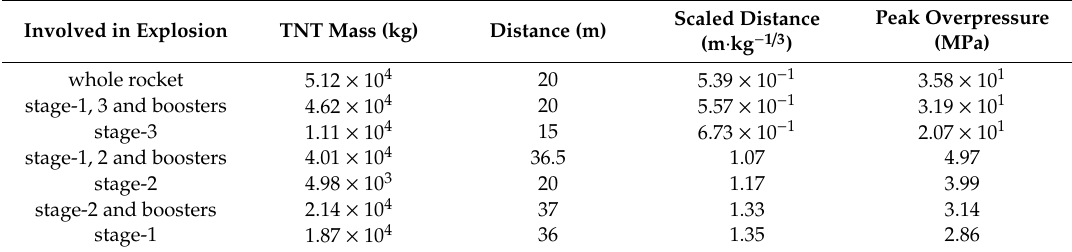
Table 11. Peak overpressures of blast wave for di ff erent stages involved in explosion.